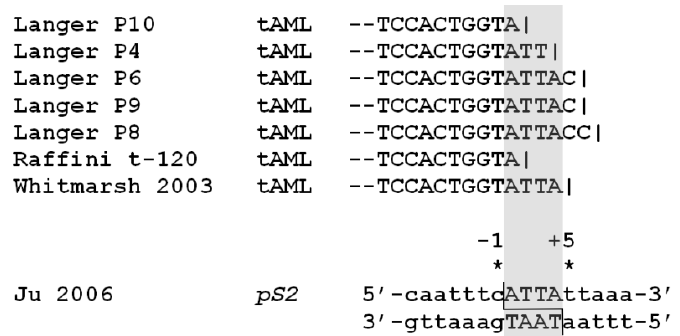
Figure 6. MLL translocation hotspot. MLL breakpoint sequences (der 11) from t-AL cases that form a “hotspot” near the telomeric end of the MLL BCR. The ATTA sequence is aligned with the same 4bp sequence identified in the etoposide-induced cleavage site described in the pS2 promoter